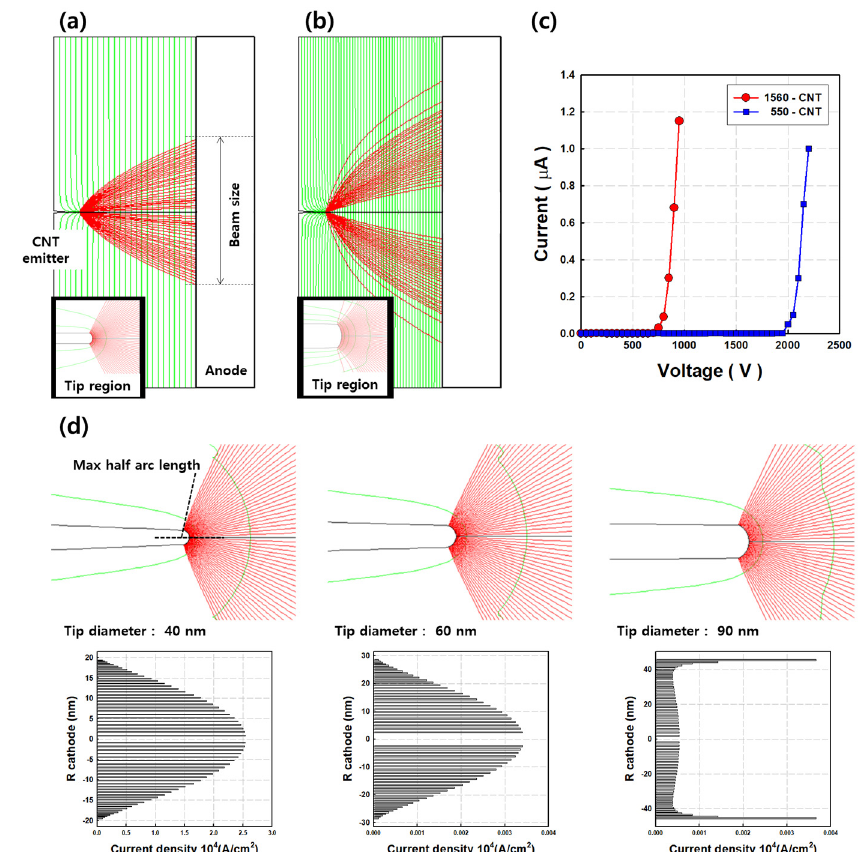
Figure 3. SOURCE 2D simulation results. ( a ) The CNT cold cathode with a geometric factor of 1560. ( b ) The CNT cold cathodes with a geometric factor of 550. ( c ) Comparison of simulated I-V curve. ( d ) Emission current density at tip region with tip diameter.